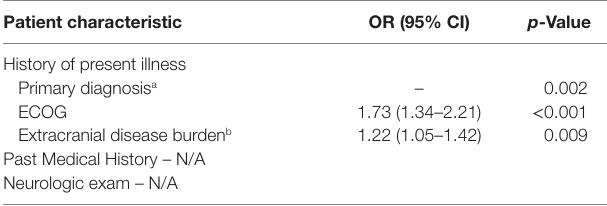
TaBle 4 | Multivariate model of overall